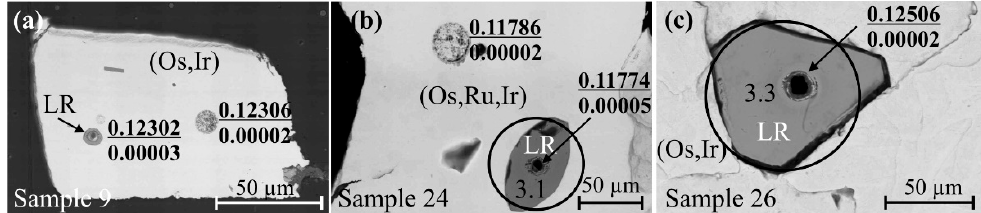
Figure 9. Back-scattered electron images of Ru-Os sulfides type 2 and associated Os-rich alloys at Verkh-Neivinsk: ( a )—sample 9, ( b )—sample 24, ( c )—sample 26. “Craters” with a diameter of 15–40 µm denote areas of Os-isotope analyses listed in Table 4. The numerals in the numerator and denominator correspond to the 187 Os/ 188 Os value and the measurement error, respectively. Black circles with a diameter ca. 100 µm denote spots of S-isotope analyses listed in Table 4. LR—laurite, (Os, Ir)—iridian osmium, (Os, Ru, Ir)—osmium.